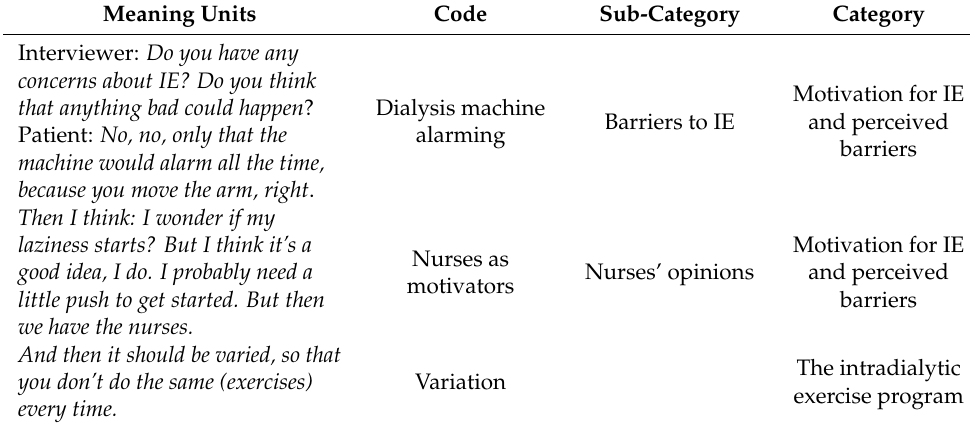
Table 2. Example of the analysis